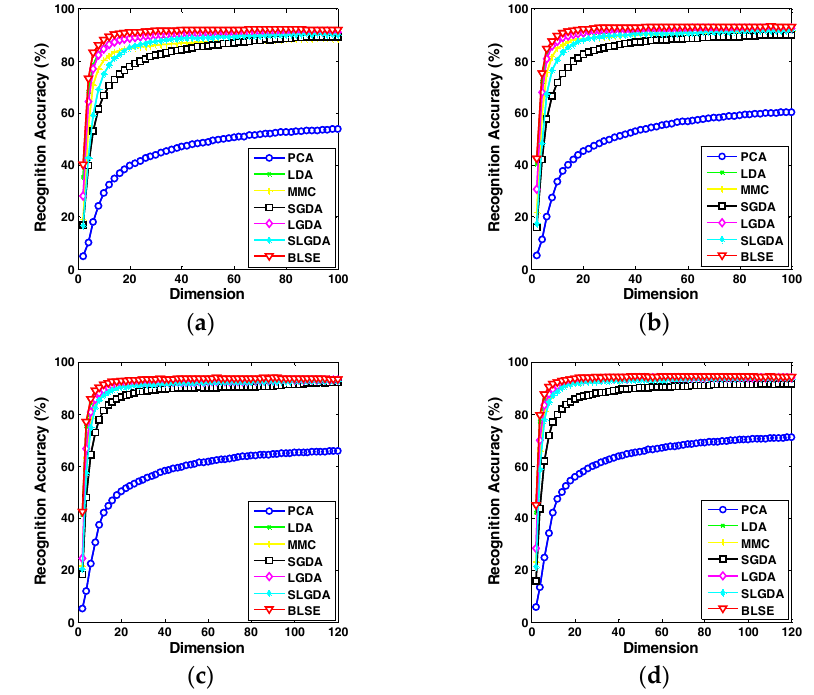
Figure 11. Recognition rate (%) versus dimension of different methods on the CMU PIE dataset. ( a ) Four training samples per person; ( b ) Five training samples per person; ( c ) Six training samples per person; ( d ) Seven training samples per person.